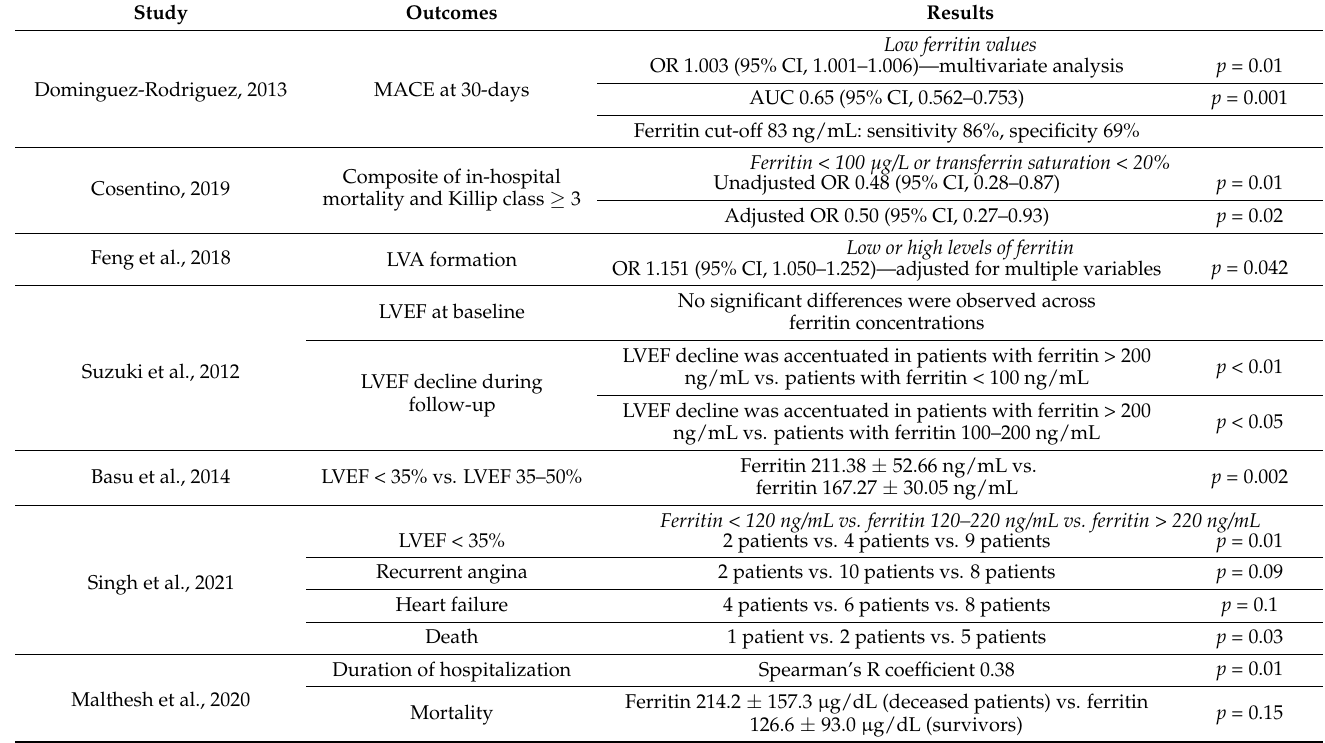
Table 2. Results reported in studies analysed in the present systematic